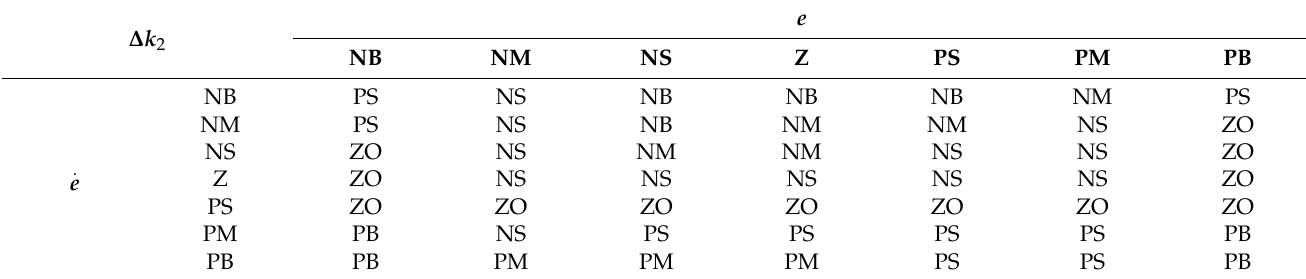
Table 3. The adjustment rules for k 2